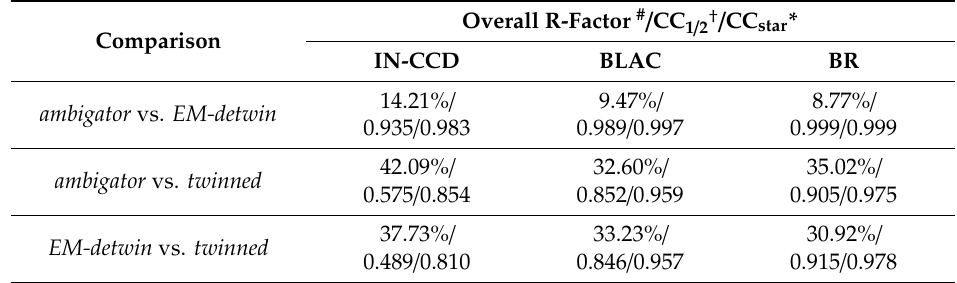
Table 3. Comparison between merged data from di ff erent